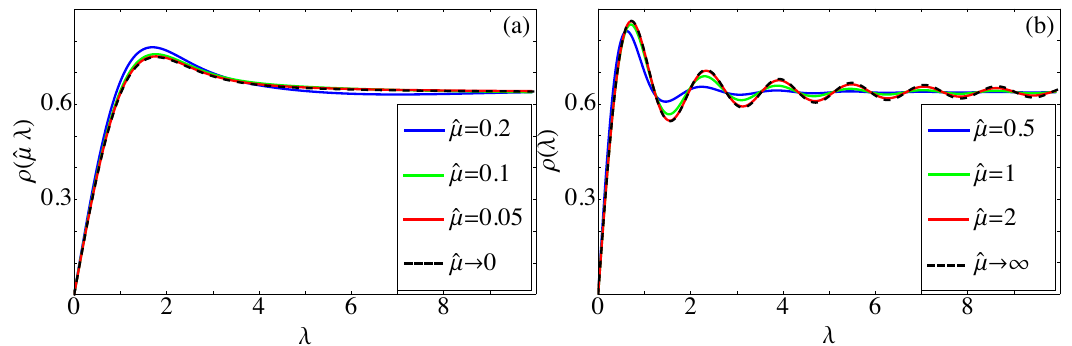
(cid:22) . In the left plot we show how the asymptotic re- b (cid:22) behaviour is shown. Please note b (cid:22) so that what is shown lies on a very b